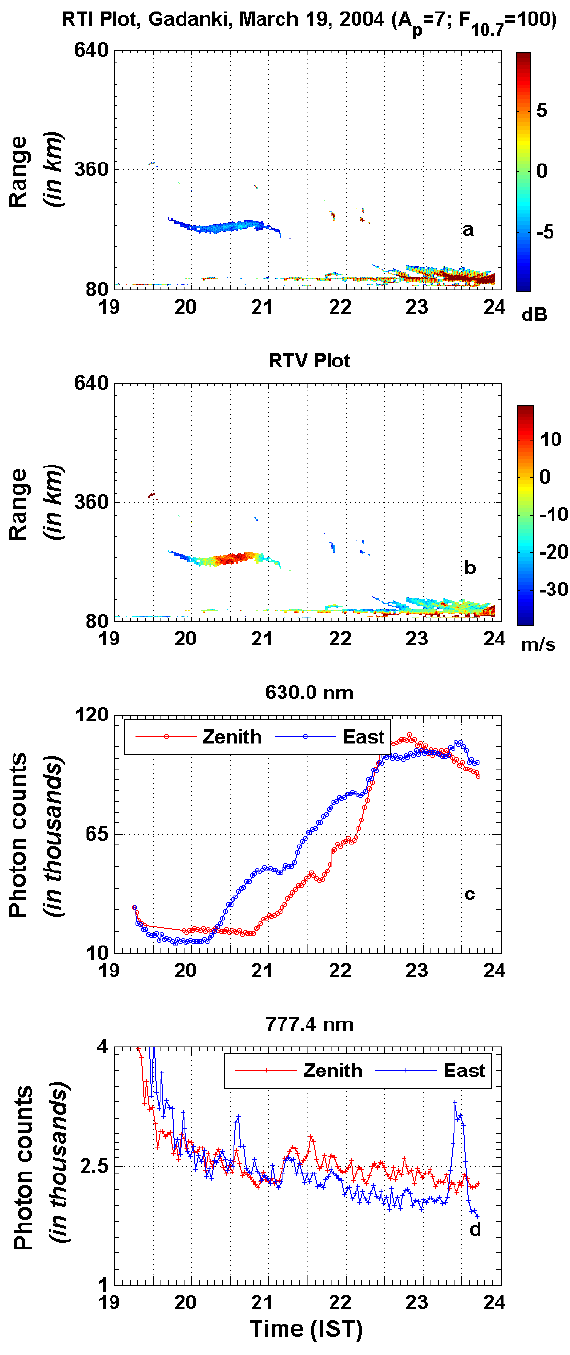
Fig. 4. Similar to Fig. 3 but for 19 March 2004 revealing bottom- side confinement of ESF structures and associated airglow intensity